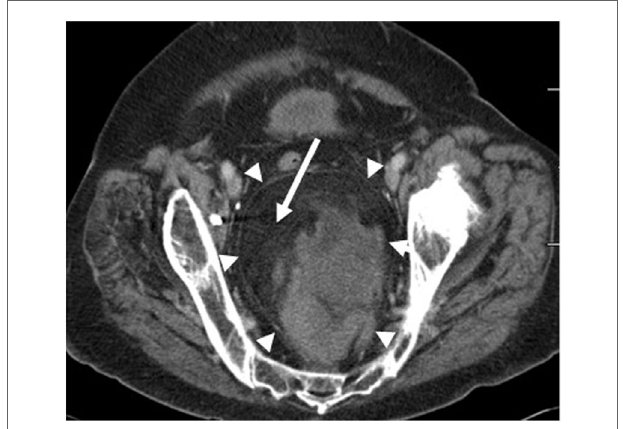
FiGURe 1 | Axial CT image of the pelvis demonstrates a large fat containing mass within the presacral region (arrowheads). Fat within the mass is dark on the CT images